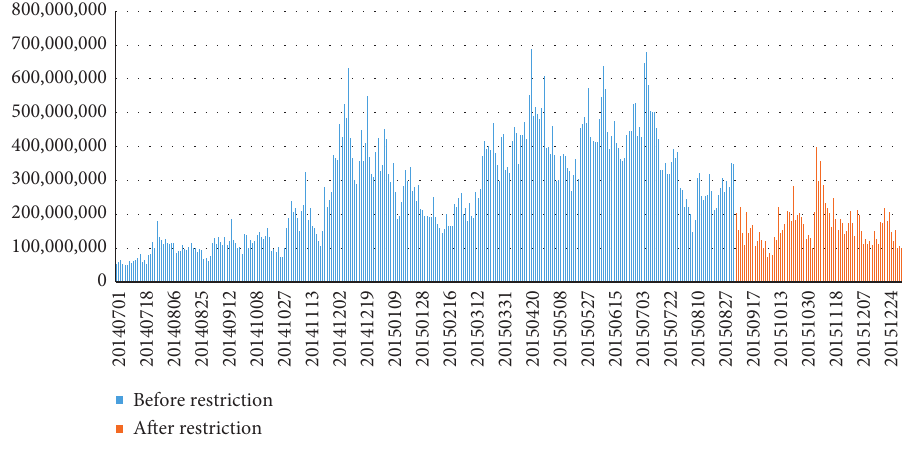
Figure 3: Volume of CSI 300 index futures before and after trade restriction (2014.7.1–2015.12.31). Table 2: Experimental